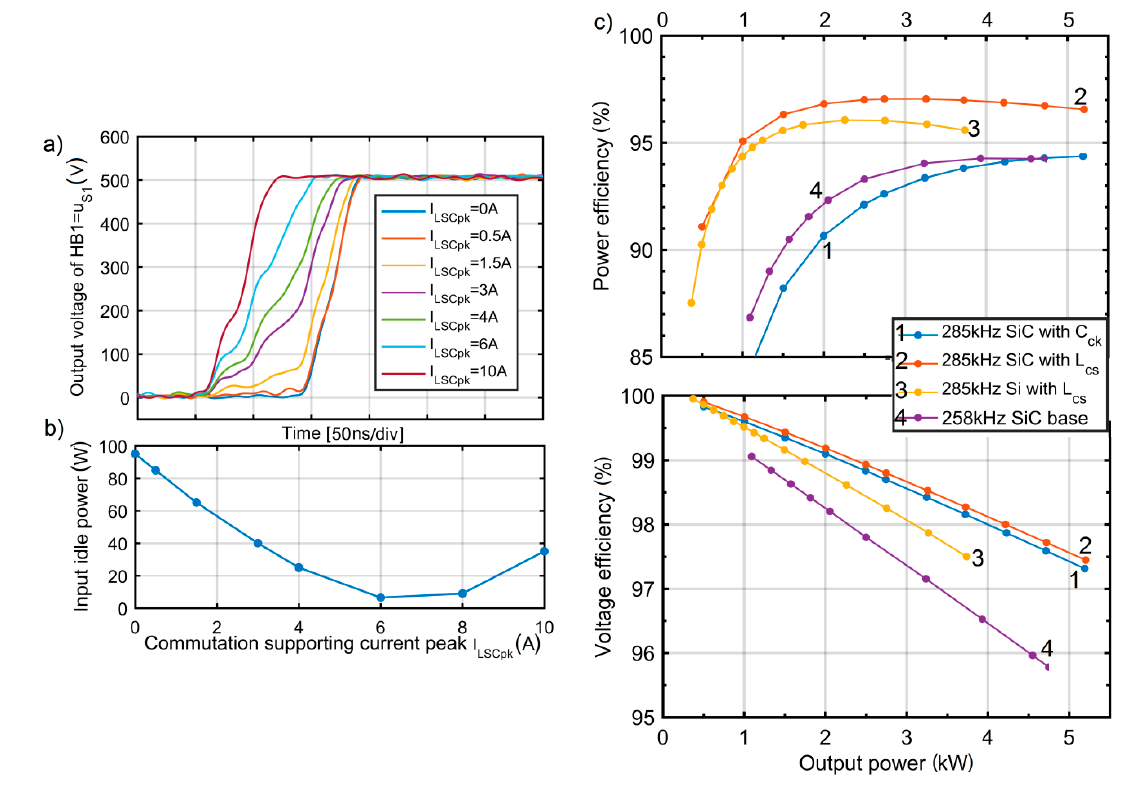
Figure 9. Experimental results: ( a ) waveforms of voltage rising slope HB1. ( b ) idle power losses of the single MRSCC converter-SiC design 285 kHz, ( c ) Power and voltage efficiency characteristics vs. output power for different configurations of the cascaded setup. Yokogawa WT1800 Precision Power Analyzer.